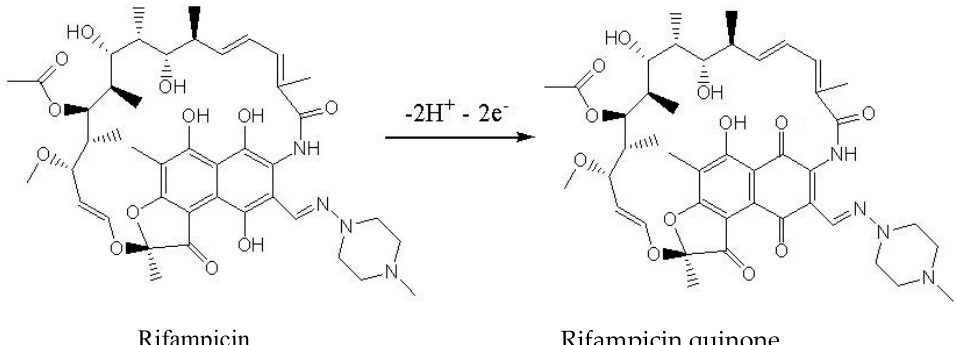
Figure 4. ( A ) CVs of RIF at the MWCNTs-CeO 2 nanorods/GCE in 0.1 M PBS with different pH (a— 5.0, b—6.0, c—7.0, d—8.0, e—9.0); ( B ) The relationship between the reduction peak current and pH; ( C ) The relationship between the peak potential and pH (The reduction peak potential (blue) and The oxidation peak potential (red)). Scan rate: 0.10 V/s.